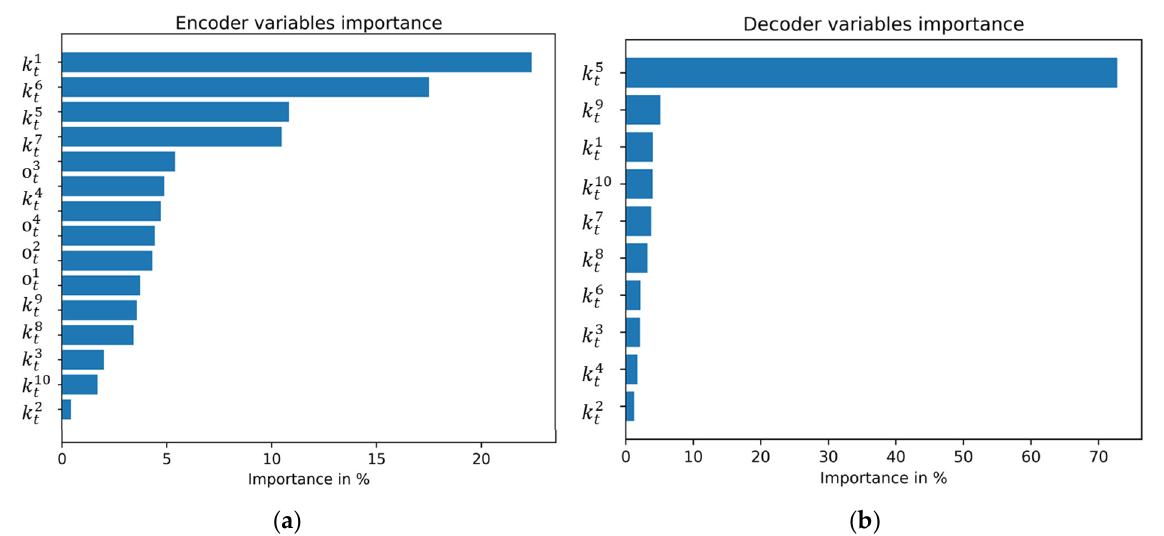
Figure 6. Variable importance for the CQMetro dataset. ( a ) Encoder variables importance. ( b ) Decoder variables importance.